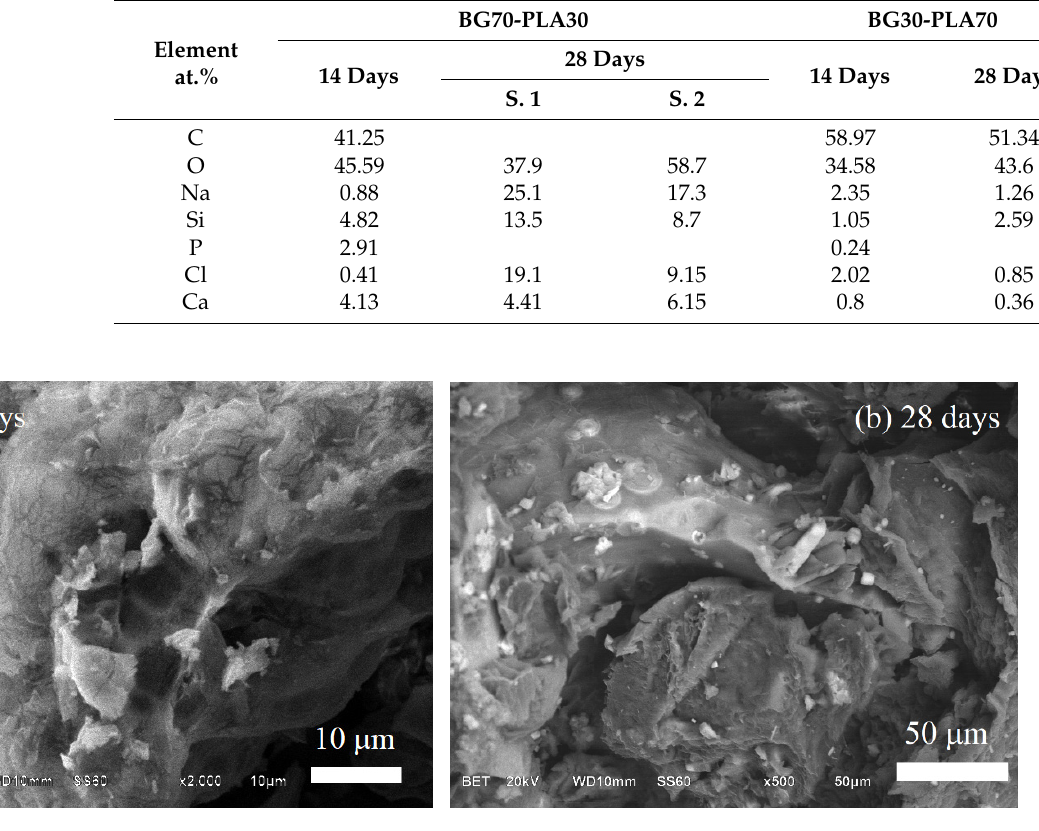
Figure 10. EDS analysis for BG30-PLA70 after ( a ) 14 and ( b ) 28 days of immersion in SBF.